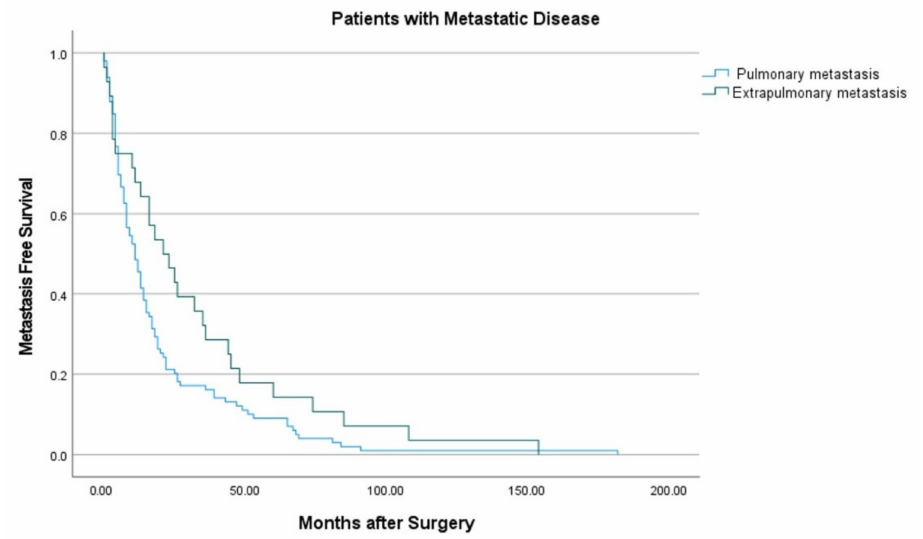
Figure 2. Kaplan–Meier curves for metastasis-free survival demonstrate that initial extrapulmonary metastases occurred later than initial pulmonary metastases (log rank p = 0.049).